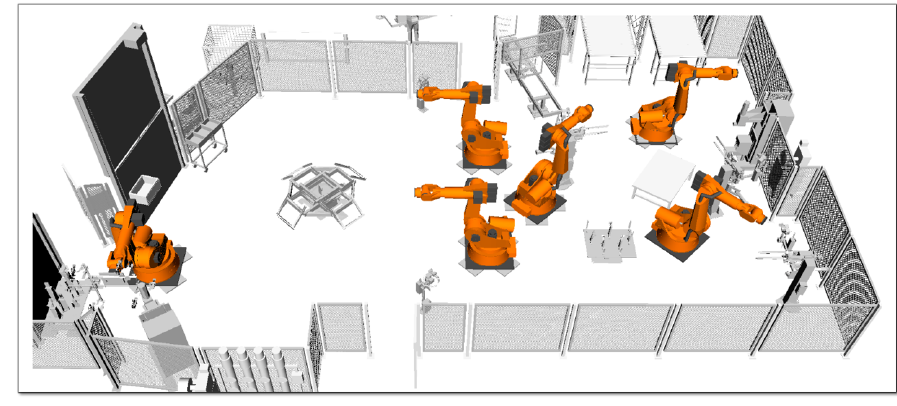
Figure 10. Line 9BC at Ford Almussafes (Valencia).